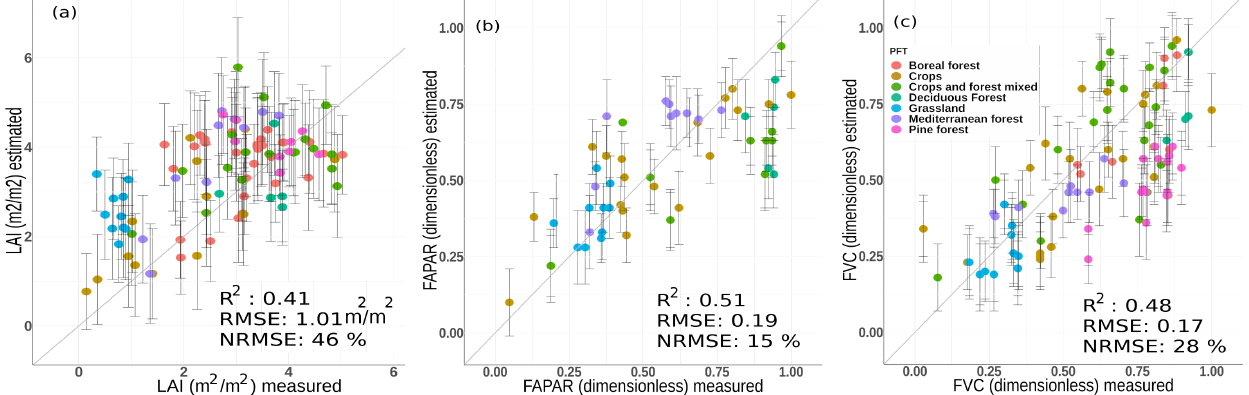
Figure 9. Scatter plots of predicted vegetation traits LAI ( a ), FAPAR ( b ) and FVC ( c ) by OLCI GPR models vs. interpolations based on ground measurements of the VALERI campaigns. The vertical bars show the obtained estimated uncertainty ( σ